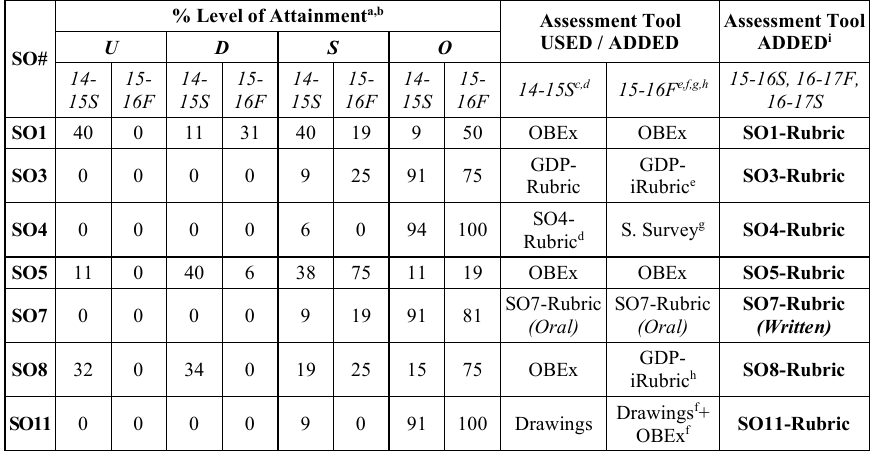
Drawings f + Drawings OBEx f